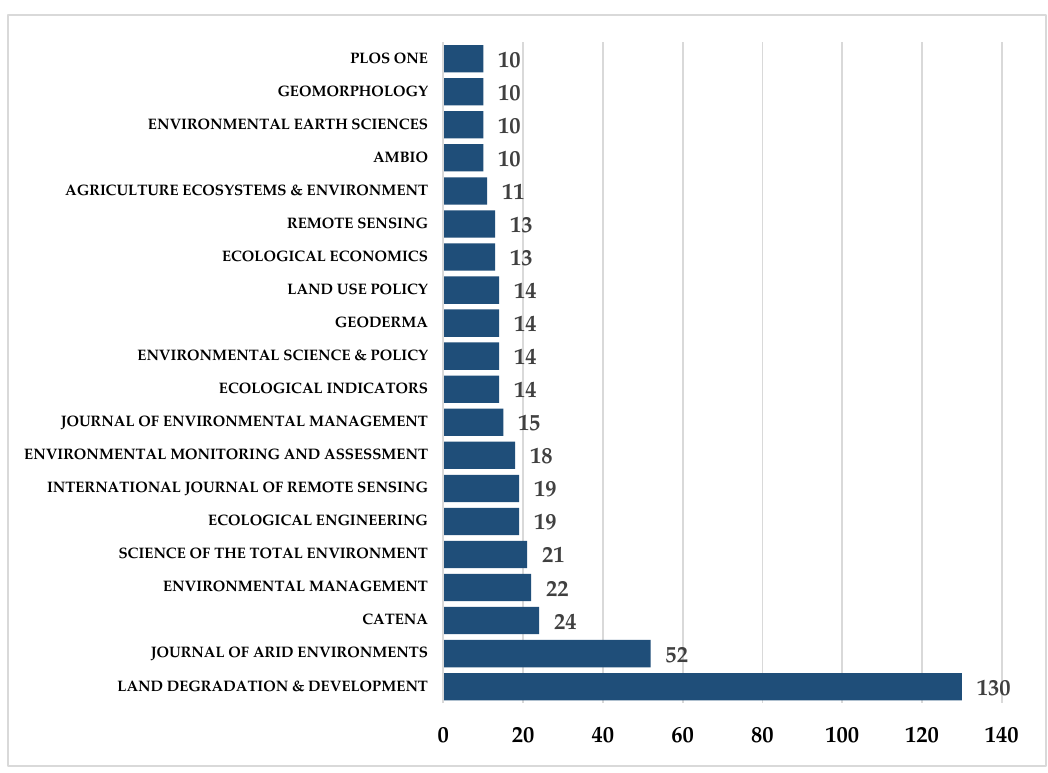
Figure 14. Top 30 journals with regard to land degradation papers.